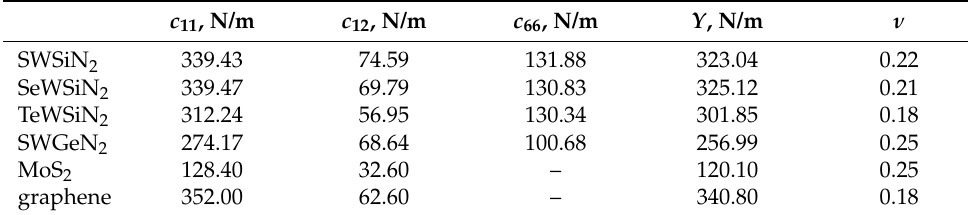
Table 3. Elasticity moduli, Young’s modulus Y , Poisson’s ratio ν for Janus monolayers X-W-AN 2 (X = S, Se, Te, A = Si, Ge), compared with those for graphene and